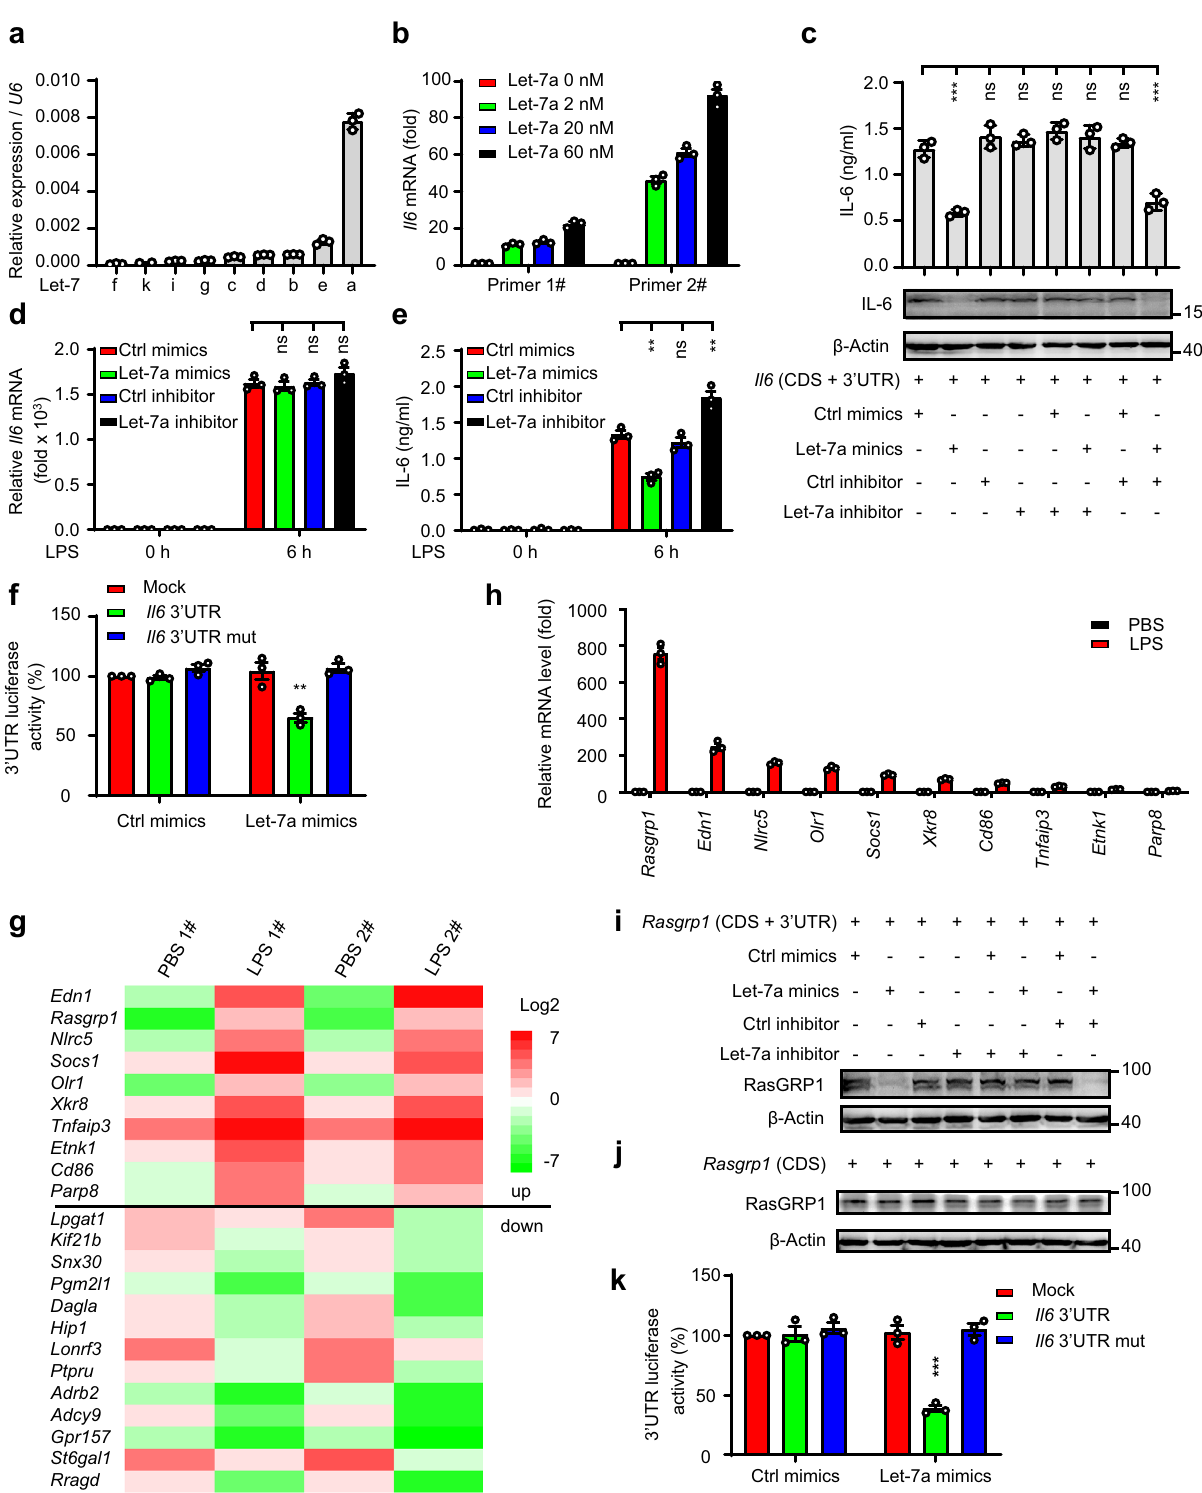
(Fig. 2f) for different durations.In addition, westimulated mousebone marrow-derived macrophages with 100ng/ml LPS, 10 μ g/ml poly (I:C) or 5 μ g/ml CpG ODN for different durations. We observed that the Rasgrp1 and Il6 expression levels were quickly and signi fi cantly upre- gulated in a time-dependent manner (Supplementary Fig. 2d –